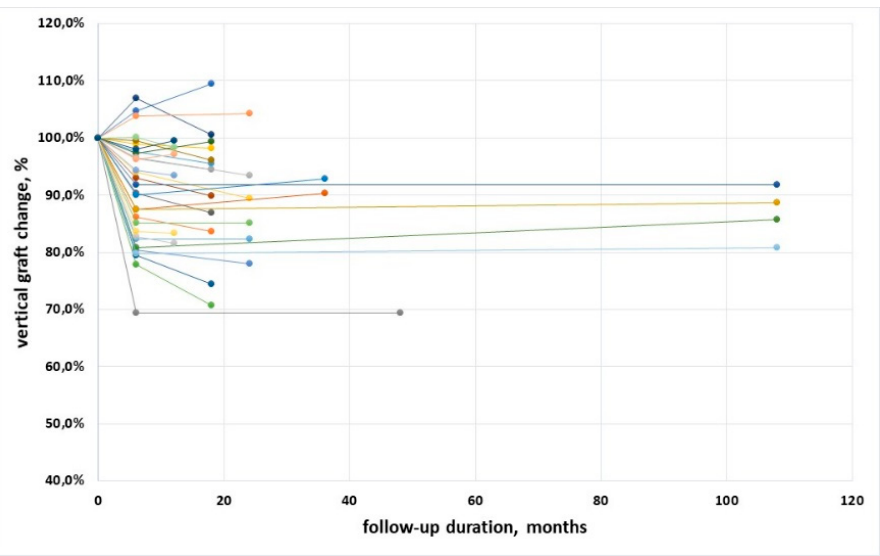
Figure 5. Trend of the vertical dimension along follow-up for all implants, expressed in percentage. Different color lines represent different patients.